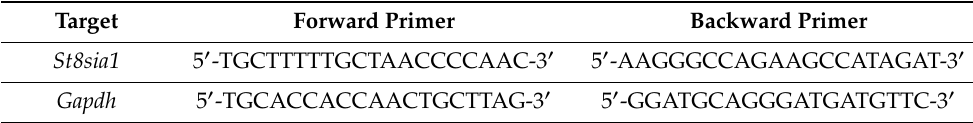
Table 1. Real-time PCR primers used in this